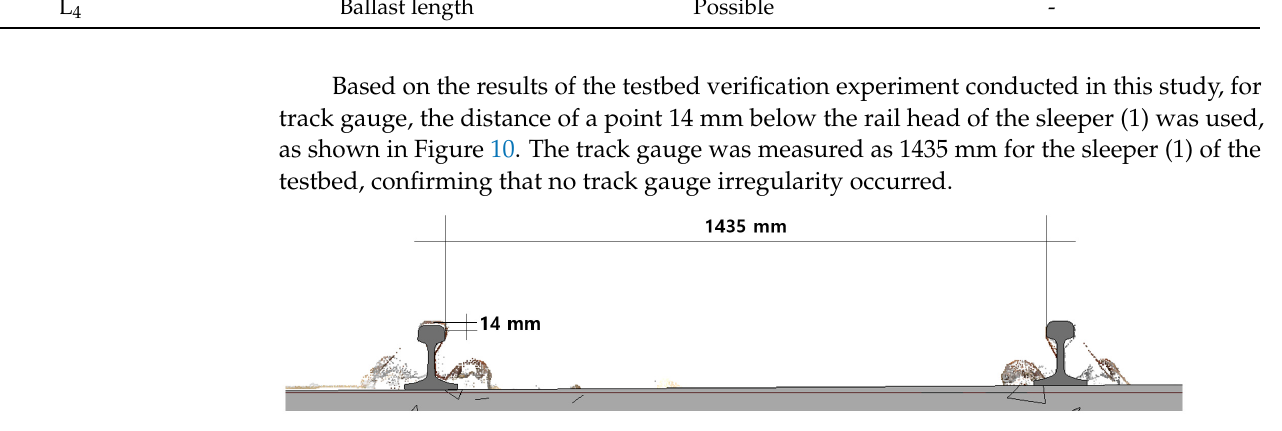
Figure 9. Testbed 3D scanning BIM model.